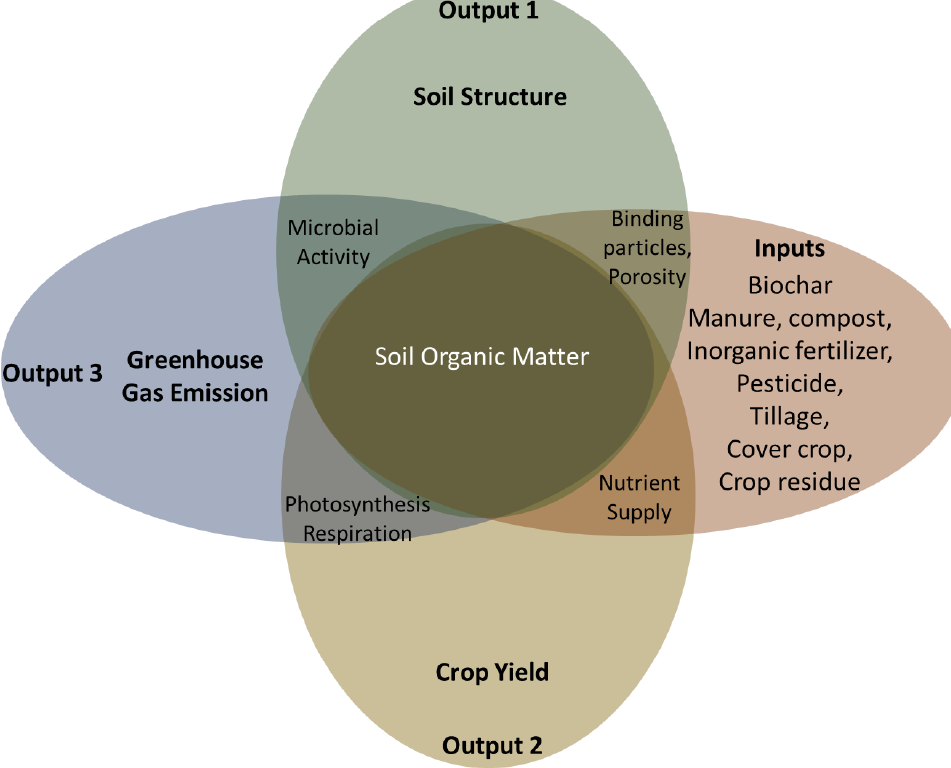
Figure 3. The carbon movement through soils and coupled correlation with other soil and crop properties.